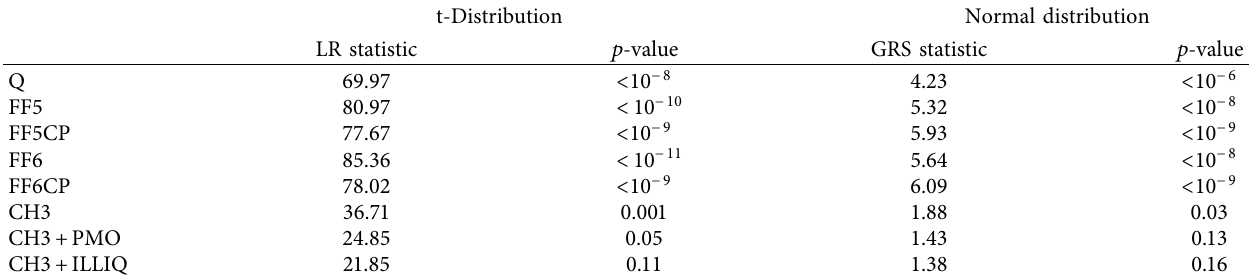
Table 7: Candidate models’ ability to explain the anomalies jointly.